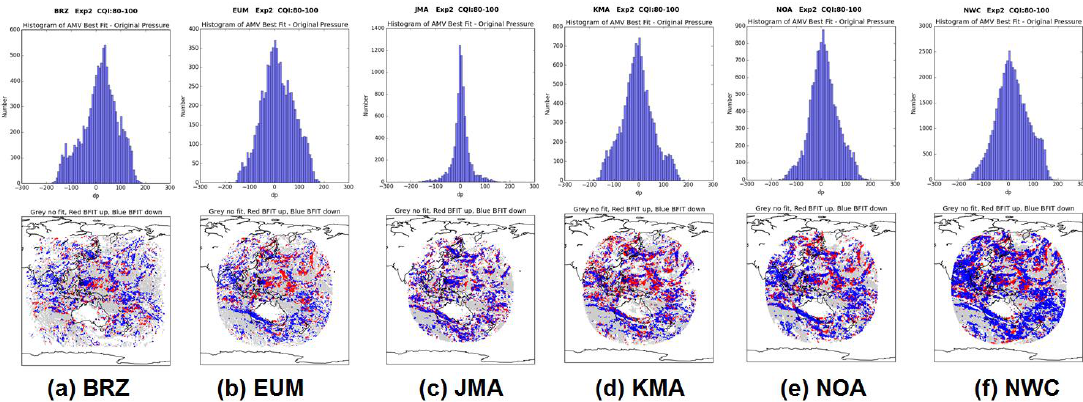
Figure 9. Histogram (upper) and maps (lower) of the di ff erence ‘AMV best-fit pressure level—AMV pressure level’ for ( a ) BRZ, ( b ) EUM, ( c ) JMA, ( d ) KMA, ( e ) NOA, ( f ) NWC. In the maps, red shows the best-fit pressure at a higher level; blue shows the best-fit pressure at a lower level.